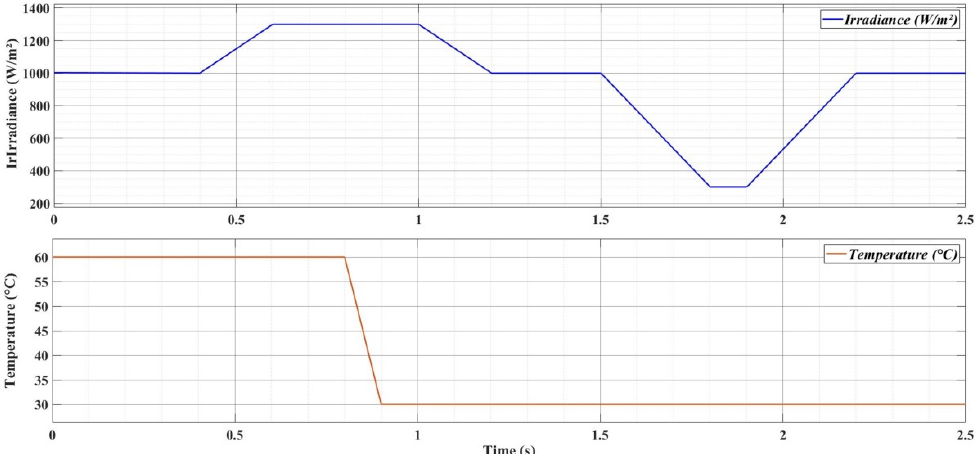
Figure 38. The time evolution of irradiance and temperature (signal evolution of the type 2 PV array).